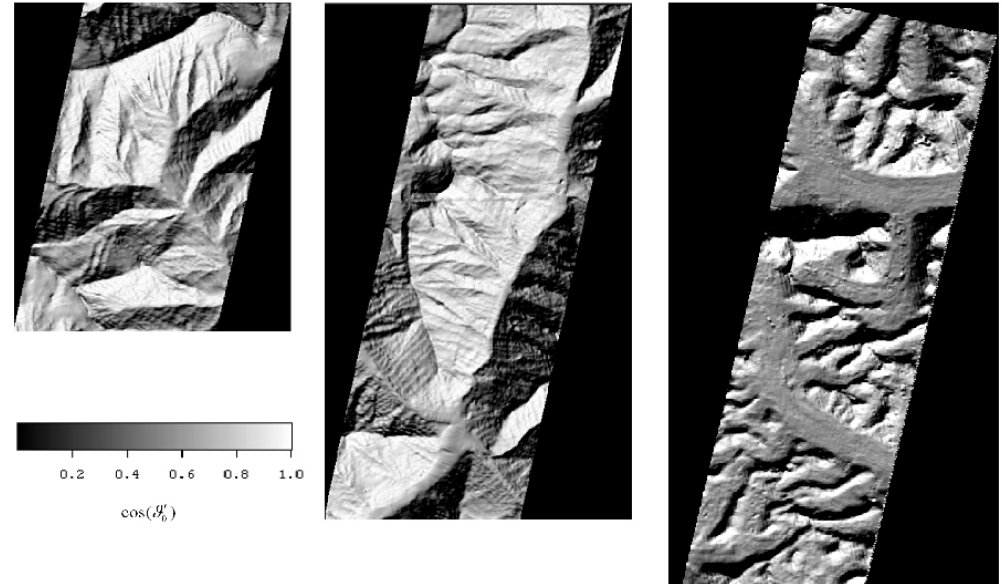
Fig. 3. The local incidence angle images generated using DEM for all the study